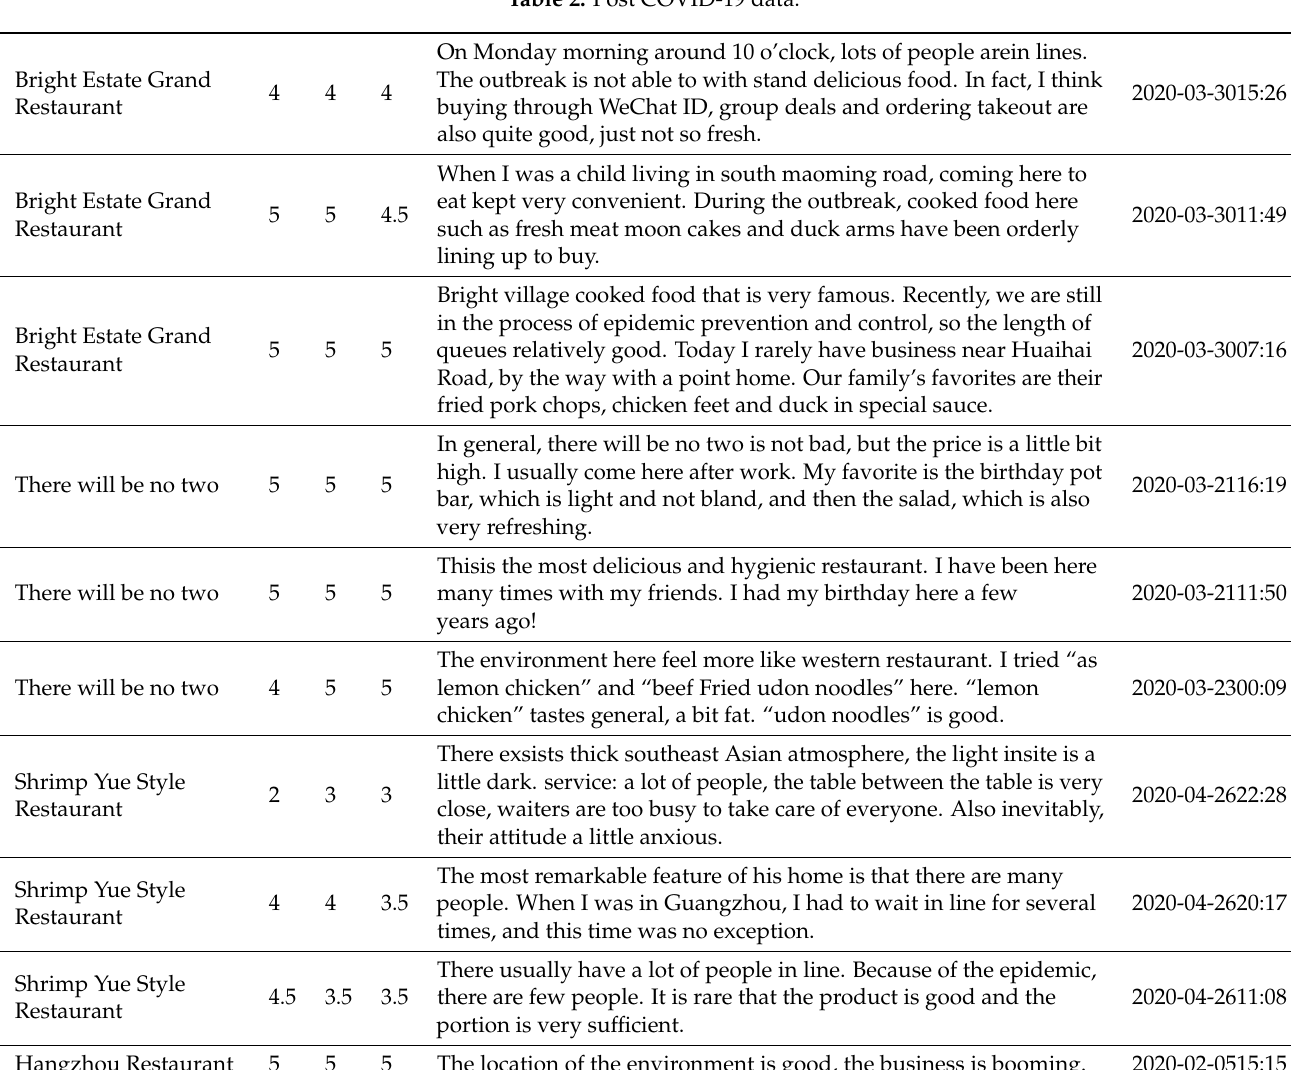
Table 2. Post COVID-19